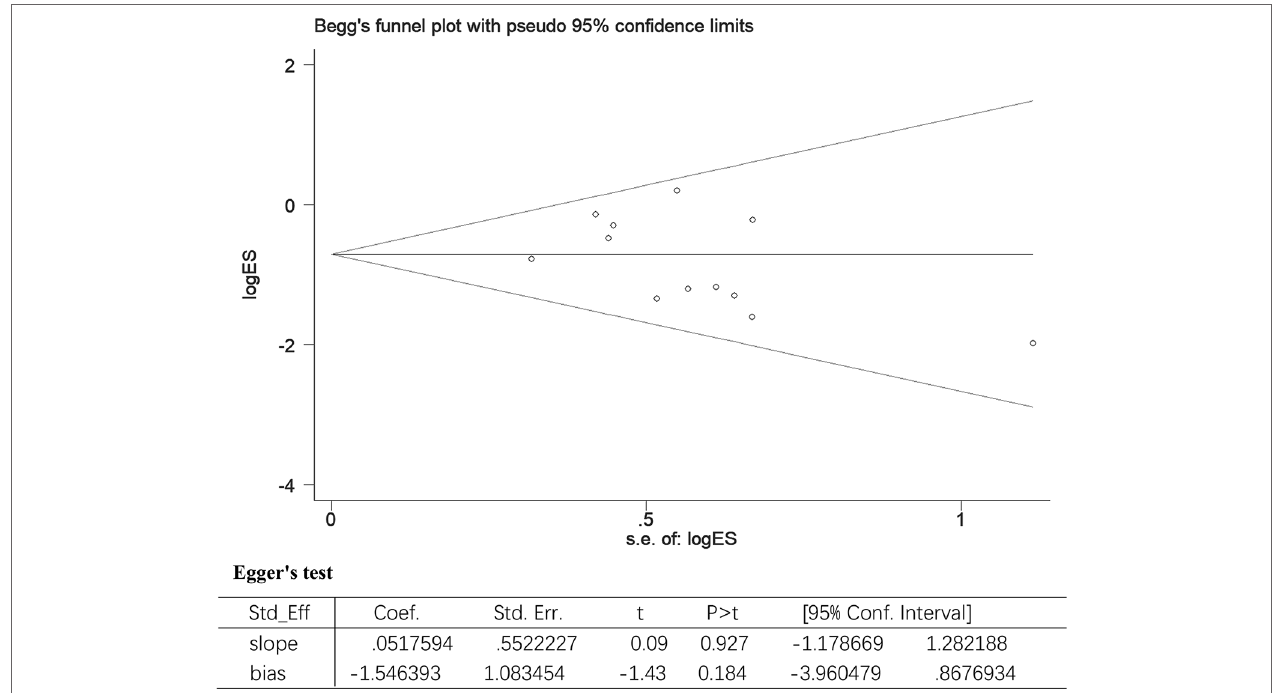
FIGURe 6 | The Begg’s test and Egger’s test for all-cause-mortality. Begg’s test: rank correlation test; Egger’s test: linear regression method; ES, effect size; 95% CI, 95% confidence interval.